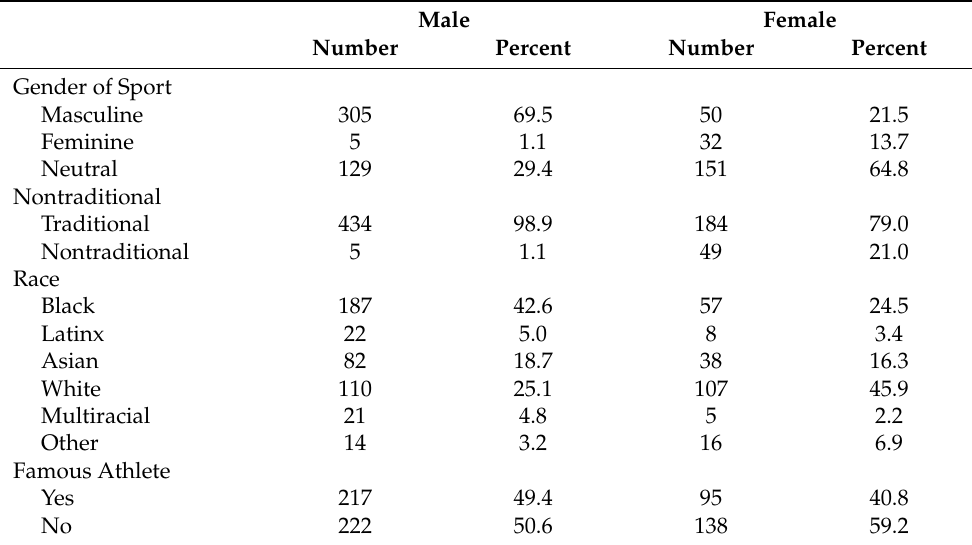
Table 3. Demographics of athletes included in Nike commercials,